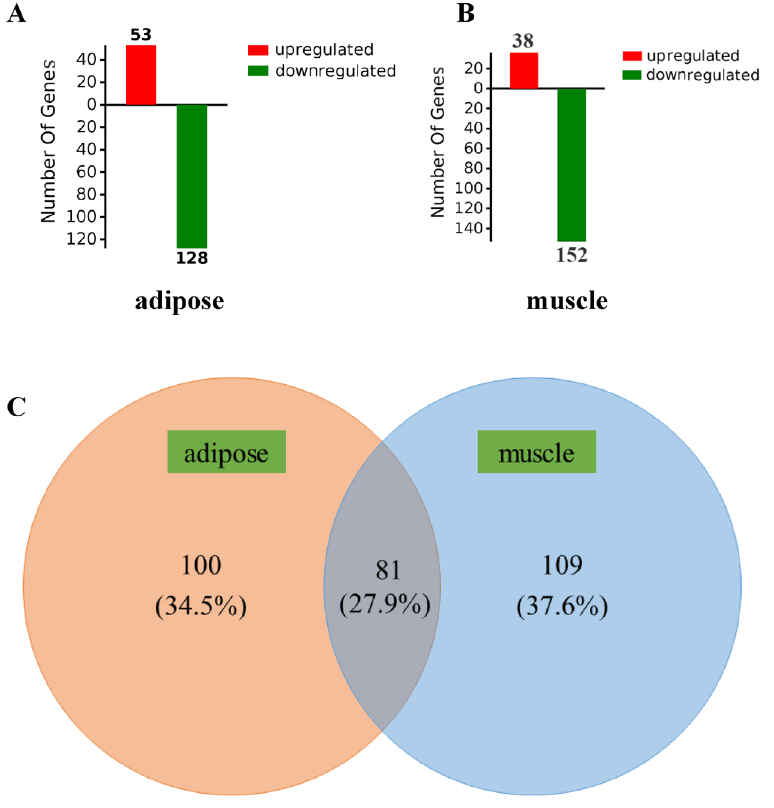
Figure 1. Numbers for common and specific differentially expressed genes (DEGs) between muscle and adipose tissues in response to intravenous infusion of sodium butyrate. ( A , B ) Red or green, respectively, represents the numbers of upregulated or downregulated genes. ( C ) Venn diagram of DEGs between different